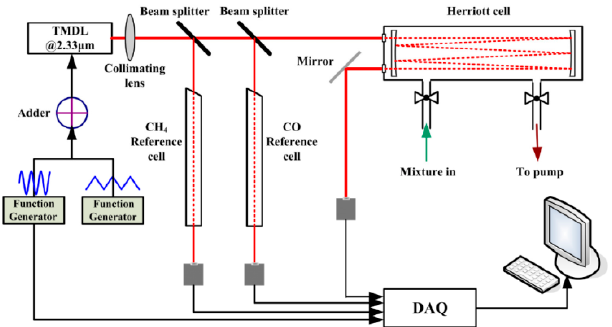
Figure 3. The experimental setup used for the simultaneous measurement of CH 4 and CO. Reproduced with permission from [95], Optical Society of America, 2016.